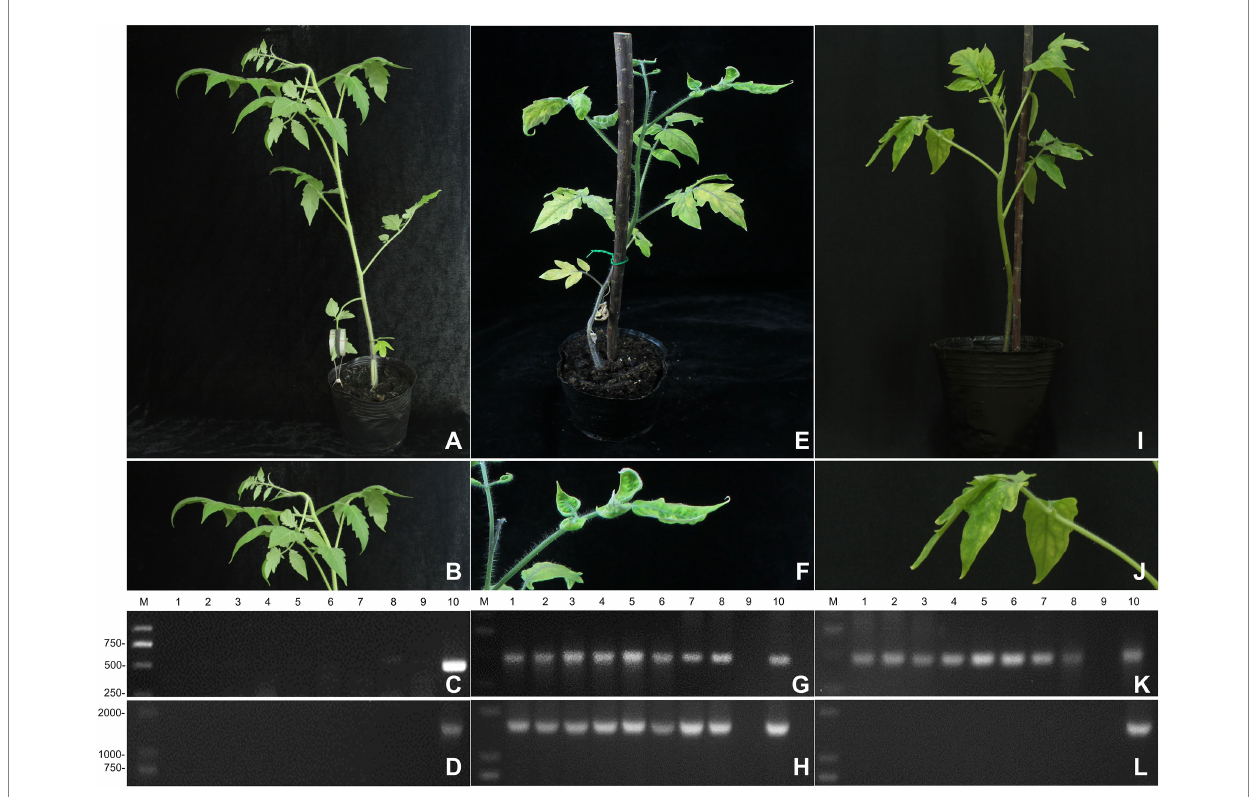
FIGURE 1 The infection of plants. (A) The symptoms of non-infected tomato plants. (B) Detailed symptoms of non-infected tomato plants. (C) Detection of ToCV in non-infected tomato plants by RT-PCR. (D) Detection of TYLCV in non-infected tomato plants by RT-PCR. (E) The symptoms of co-infected tomato plants. (F) Detailed symptoms of co-infected tomato plants. (G) Detection of ToCV in co-infected tomato plants by RT-PCR. (H) Detection of TYLCV in co-infected tomato plants by RT-PCR. (I) The symptoms of single-infected tomato plants. (J) Detailed symptoms of single-infected tomato plants. (K) Detection of ToCV in single-infected tomato plants by RT-PCR. (L) Detection of TYLCV in single-infected tomato plants by RT-PCR. M: DNA marker. 1–8, tomato plants samples; 9, negative control; 10, positive